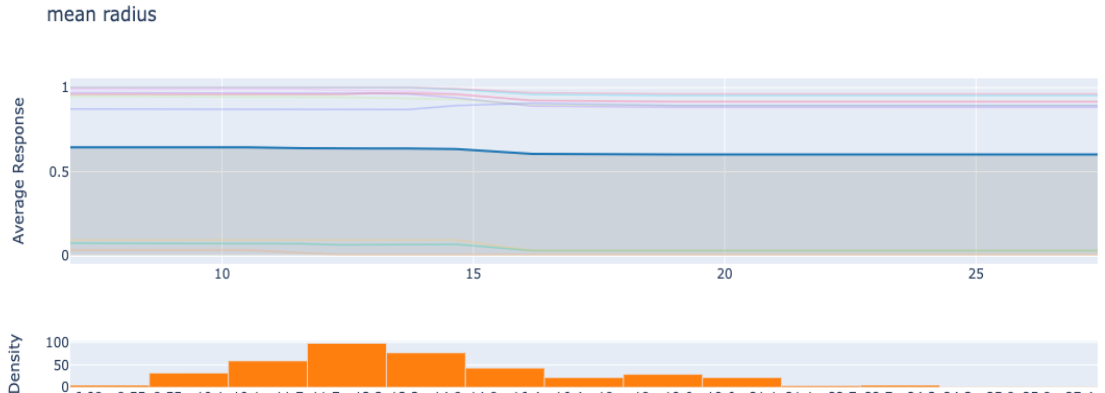
Figure 8. Interpret the black-box model ’ s decisions with PDP for the feature “ mean radius ” .